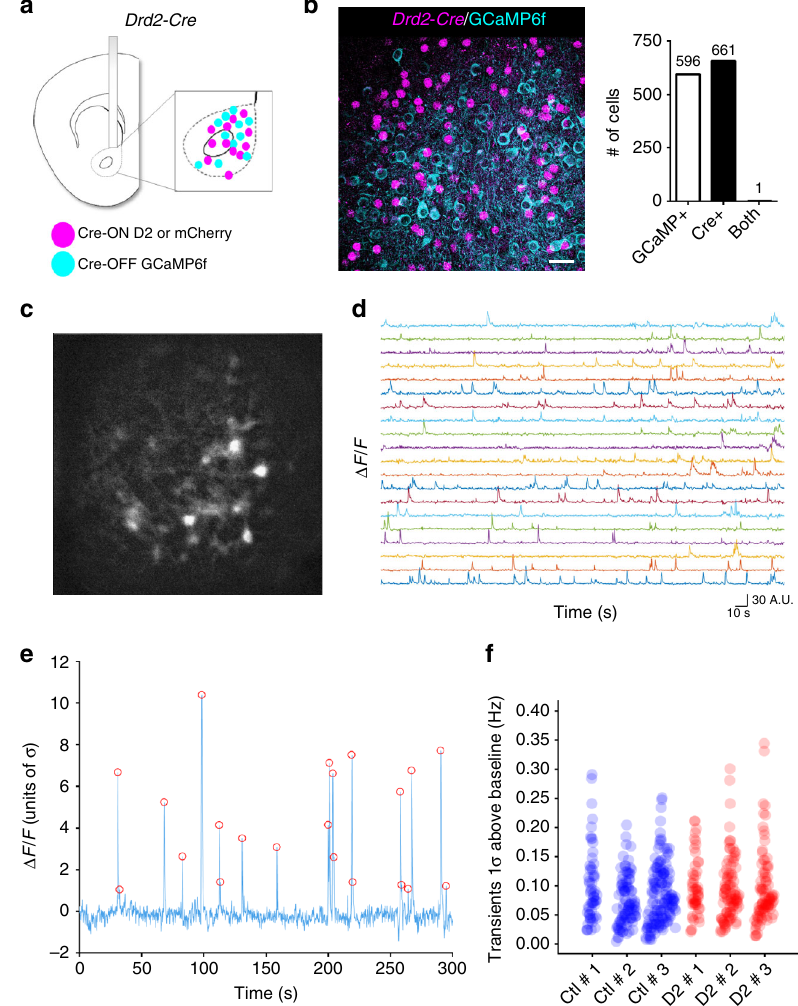
Fig. 3 D2R upregulation in D2-MSNs does not alter D1-MSN activity in vivo. a Schematic of GRIN lens lowered into the NAc core of Drd2-Cre mice transduced with a Cre-ON D2-IRES-mCherry or mCherry in Cre ( + ) cells (primarily expressed in D2-MSNs) and a Cre-OFF GCaMP6f in Cre ( – ) cells (primarily expressed in D1-MSNs). b Double immuno fl uorescence analysis against Cre and GFP shows that in a Drd2-Cre mouse, Cre-OFF GCaMP6f (cyan) expression is restricted to Cre ( – ) cells. Scale = 25 μ m. c Representative fl uorescent image from live D1-MSNs expressing Cre-OFF GCaMP6f. d Individual neural Ca 2 + transient traces from D1-MSNs in one representative mouse during progressive ratio task. e Ca 2 + transients were de fi ned as events with peak amplitudes greater than 1 standard deviation (S.D.) from baseline activity for analysis. Red circles denote transients whose amplitudes are above 1 S.D. f Frequency of Ca 2 + transients recorded during PR from individual cells in 3 mice per